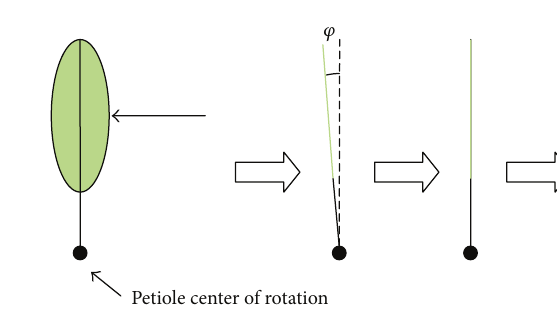
Figure 8: Leaf vibration in response to